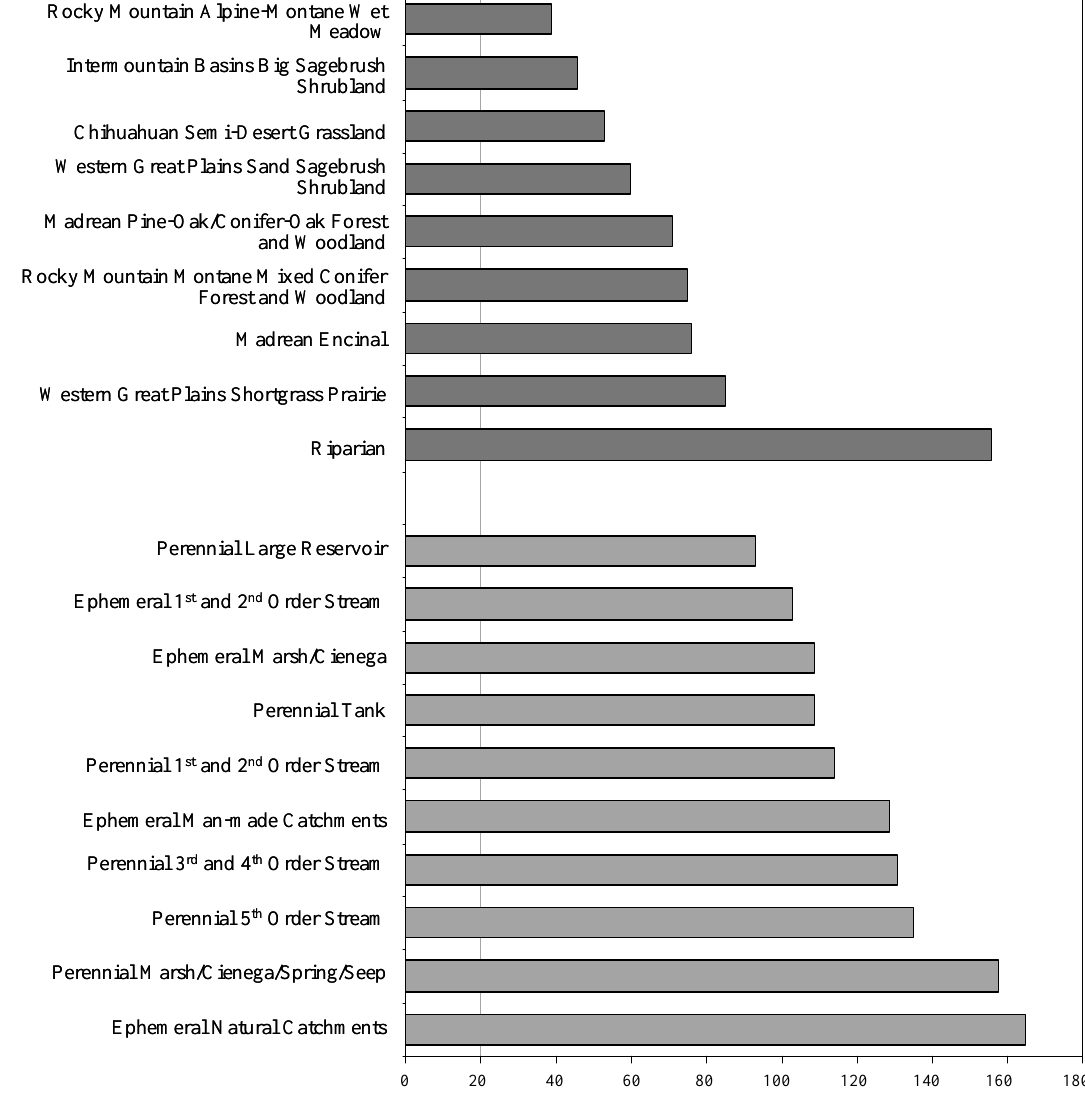
Figure 4. Cumulative magnitude scores of 43 factors that influence key habitats in New Mexico. This analysis assists in the identification of key habitats which may have the highest risk of being altered by multiple effects of factors that influence